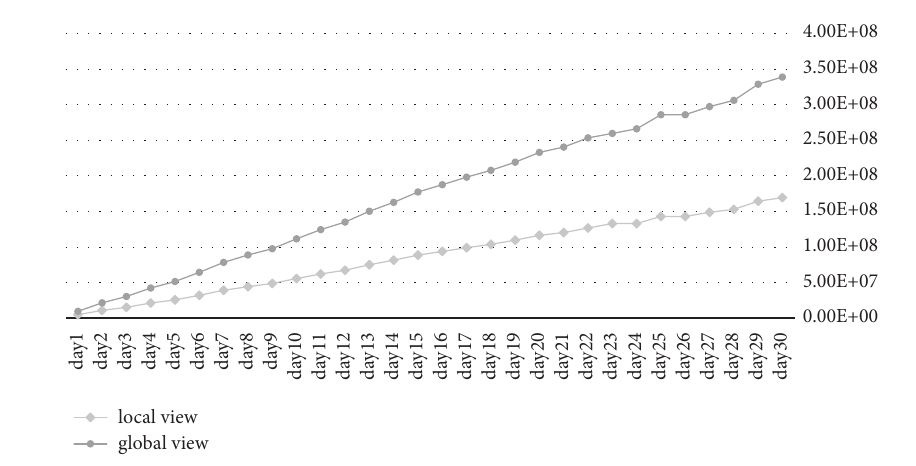
Figure 6: Total reward comparison of two multiaction dispatching optimization